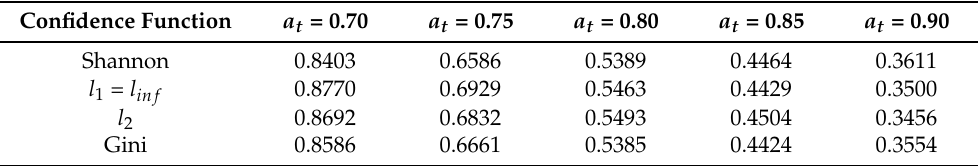
Table 2. Comparison of dataset coverage for different accuracy thresholds a t for each evaluated confidence function.